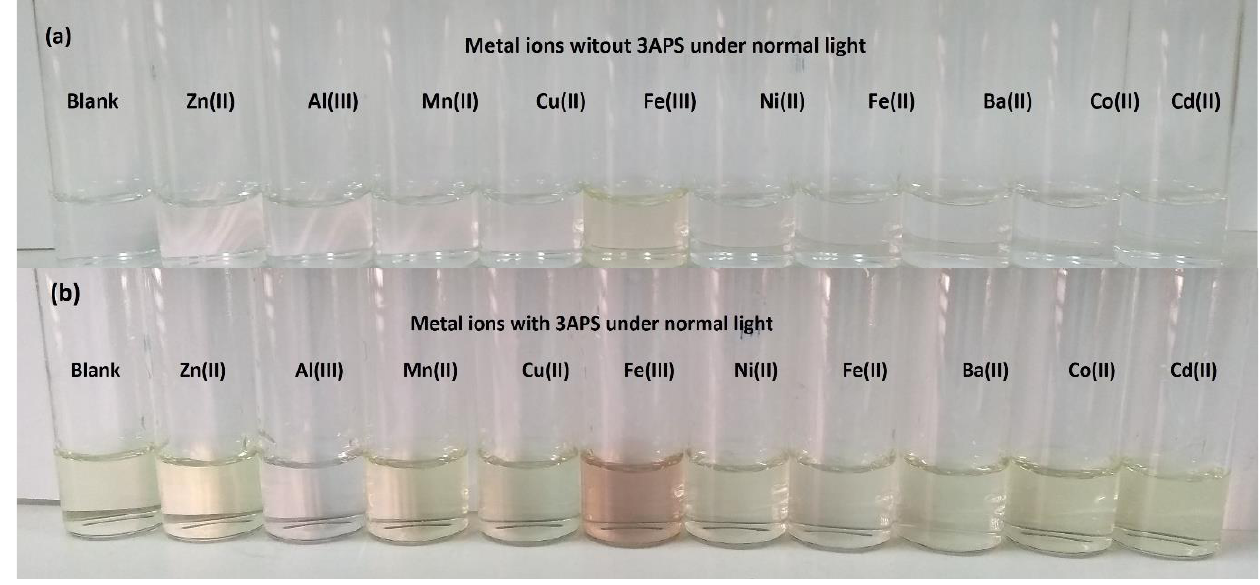
Figure 3. Visual representation of metal solutions (1 × 10 − 4 M) without ( a ) and with 3APS (2 × 10 − 5 M) ( b ) in H 2 O–ACN (9:1) under normal light.